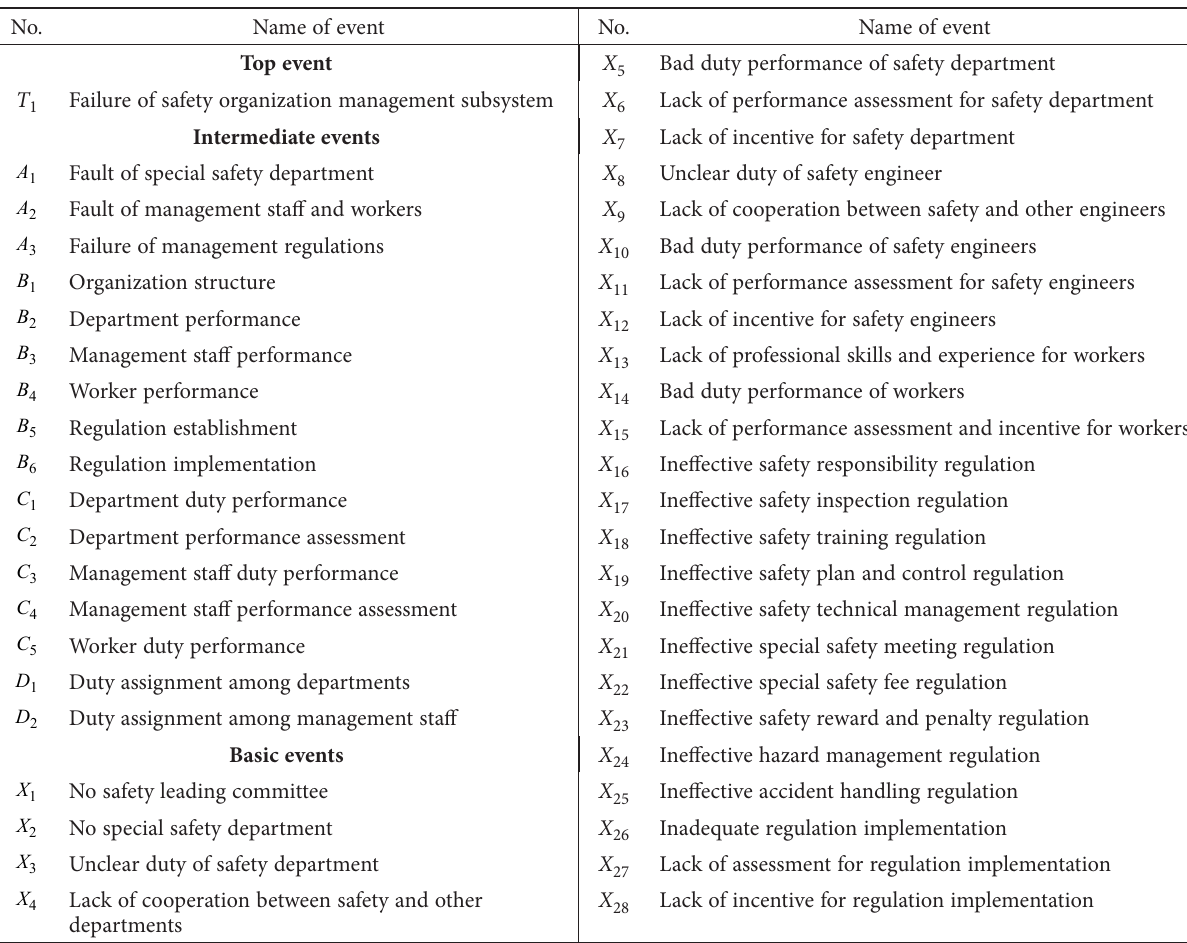
Table 3. Name of event in the fault tree